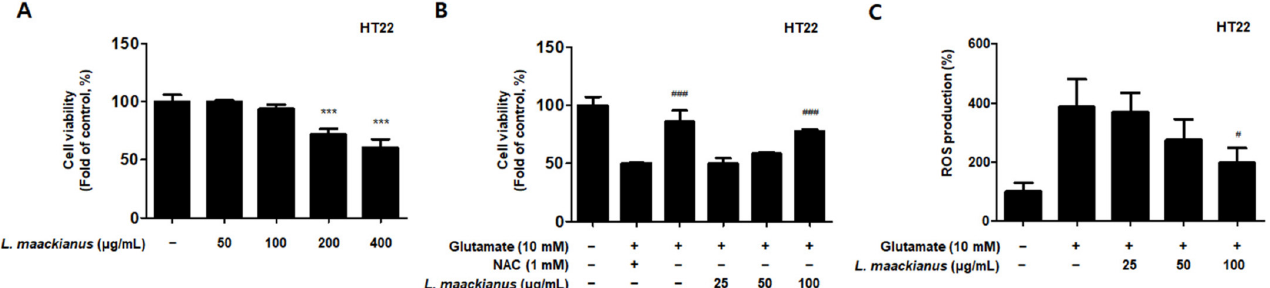
Figure 5. Neuroprotective effect of the MeOH extract of Lycopus maackianus on glutamate-induced HT22 hippocampal cells. Cells were pretreated with the indicated concentrations of extract for 3 h and analyzed in the absence ( A ) or presence ( B ) of glutamate (10 mM) for 24 h. Reactive oxygen species (ROS) generation inhibitory effect ( C ) of L. maackianus MeOH ex-tract in a glutamate-treated HT22 cell. Data are the average of three independent experiments. Untreated control groups were included. *** p < 0.001 compared with control group. # p < 0.05, ### p < 0.001 compared with glutamate-